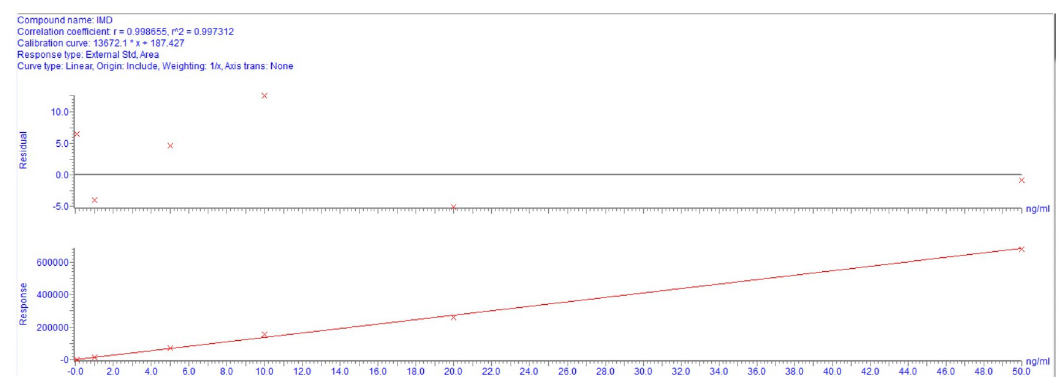
Fig 3. The calibration curves for IMD.